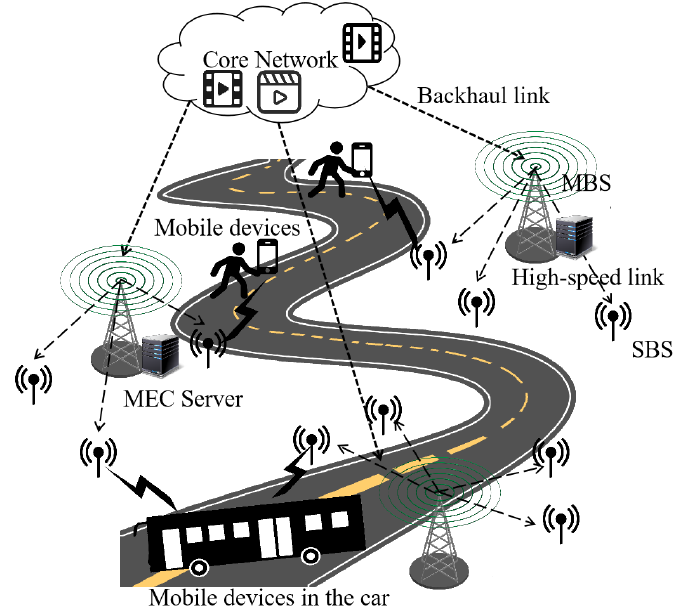
Figure 1. Edge caching scene of mobile video